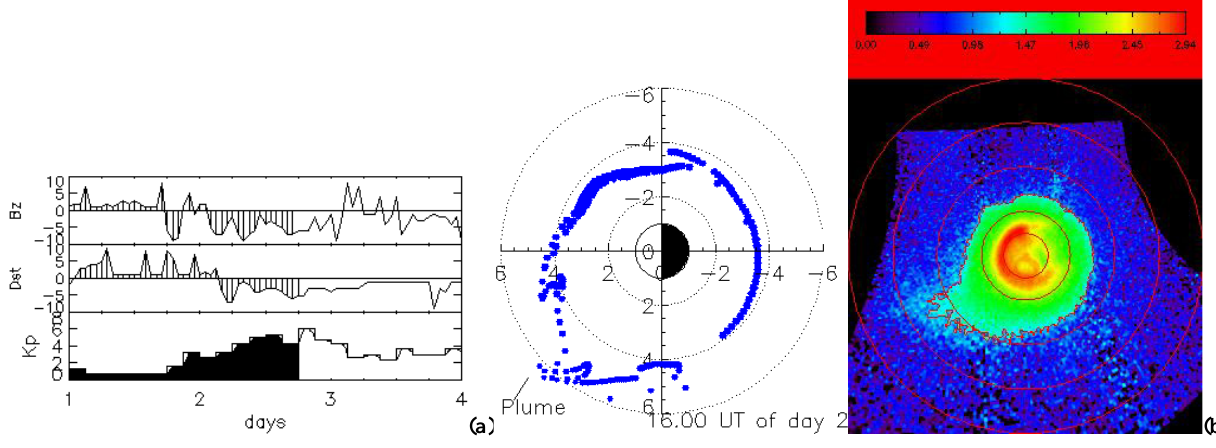
Fig. 10: Same as Fig. 1 for June 26, 2000, 16h00 (left panel (a), simulation) and 15h56 Fig. 10. Same as Fig. 1 for 26 June 2000, 16:00 UT ( (a) , simulation) and 15:56 UT ( (b) , EUV observation). UT (right panel (b), EUV observation).